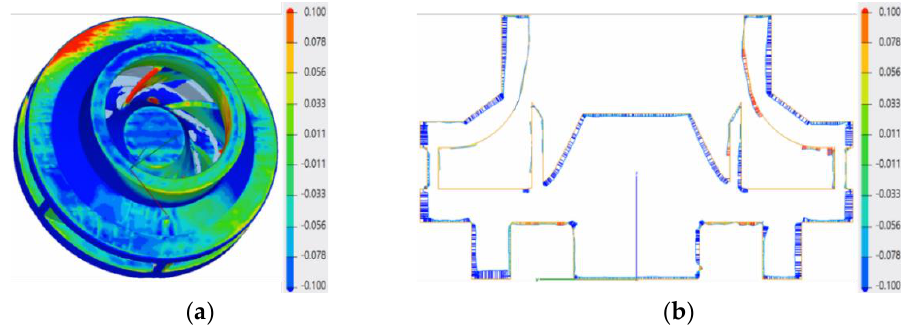
Figure 6. Dimensional evaluation: ( a ) top view; ( b ) section view.